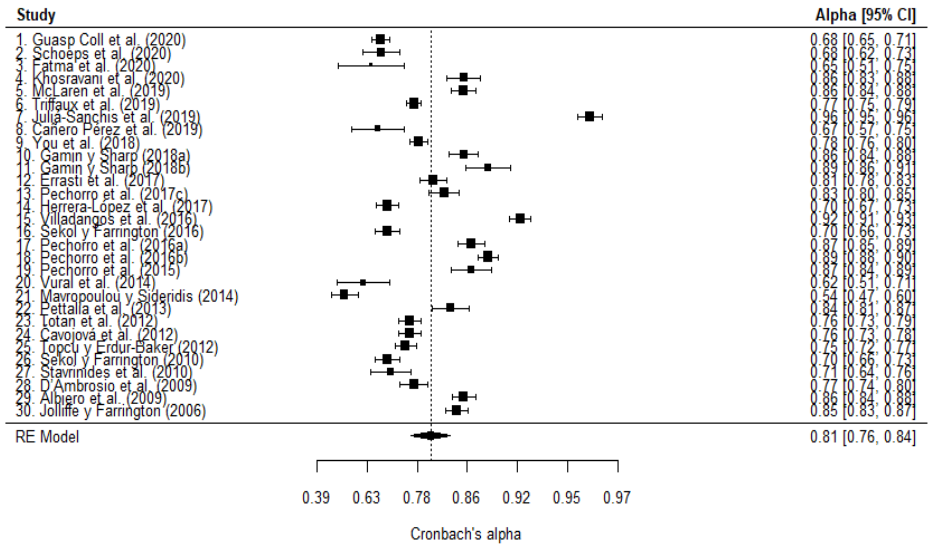
Figure 5. Forest plot of the affective empathy meta-analysis. Table 3. Descriptive statistics of Cronbach’s α for each article according to its position with respect to the global